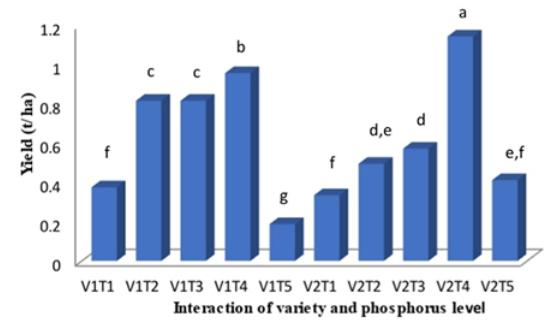
Figure 6 Interactive effect of varieties and different levels of phosphorus on mungbean